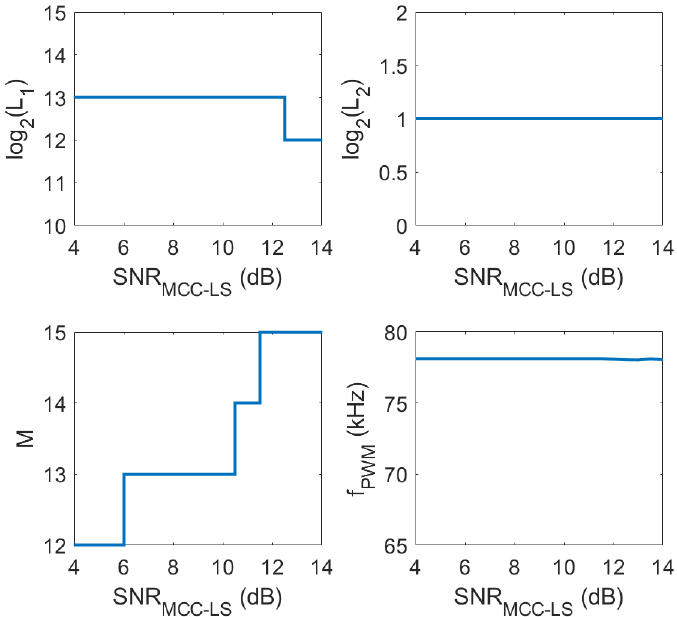
Figure 13. MCC optimized variables for spectral efficiency